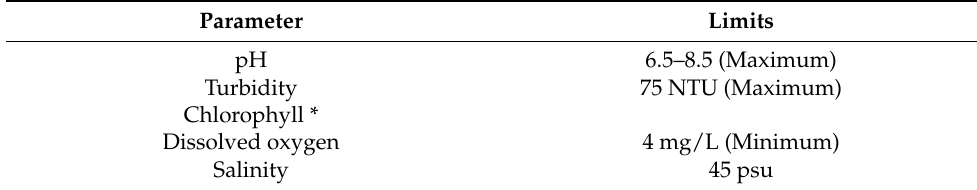
Table 3. Standard limits of KEPA for some of the study’s